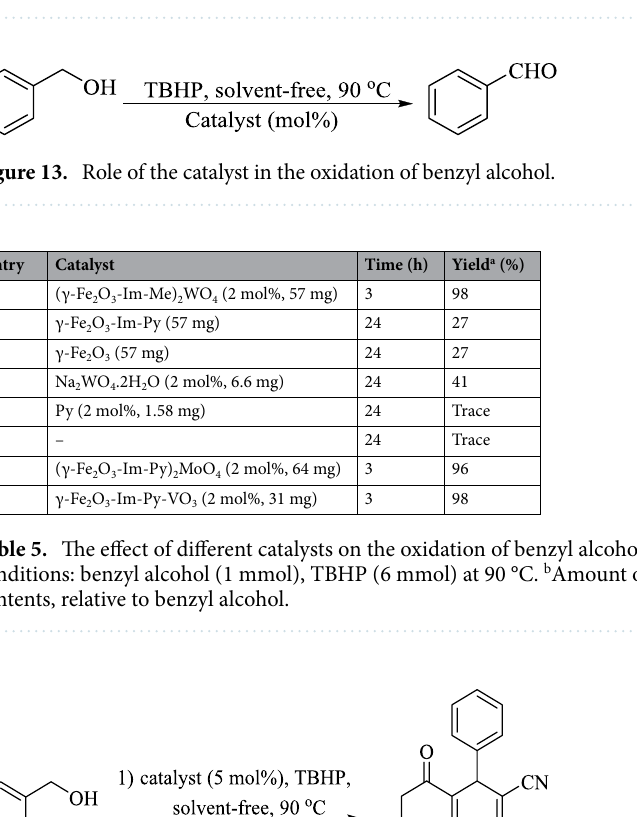
Figure 12. Chemical structure of (γ-Fe 2 O 3 -Im-Py) 2 WO 4 , (γ-Fe 2 O 3 -Im-Me) 2 WO 4 , γ-Fe 2 O 3 -Im-Py and γ-Fe 2 O 3 - Im-Me.